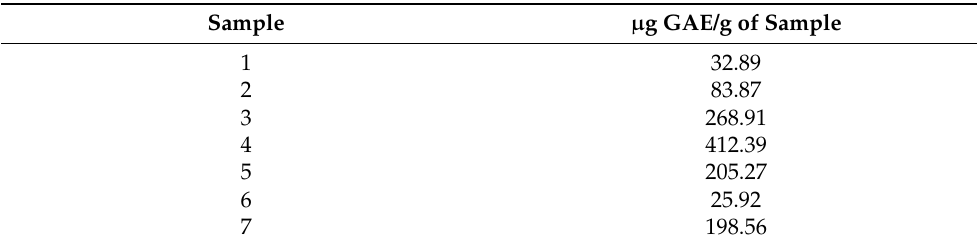
Table 7. Results expressed in µ g gallic acid equivalent per gram (GAE)/g of sample (Folin- Ciocalteu method).